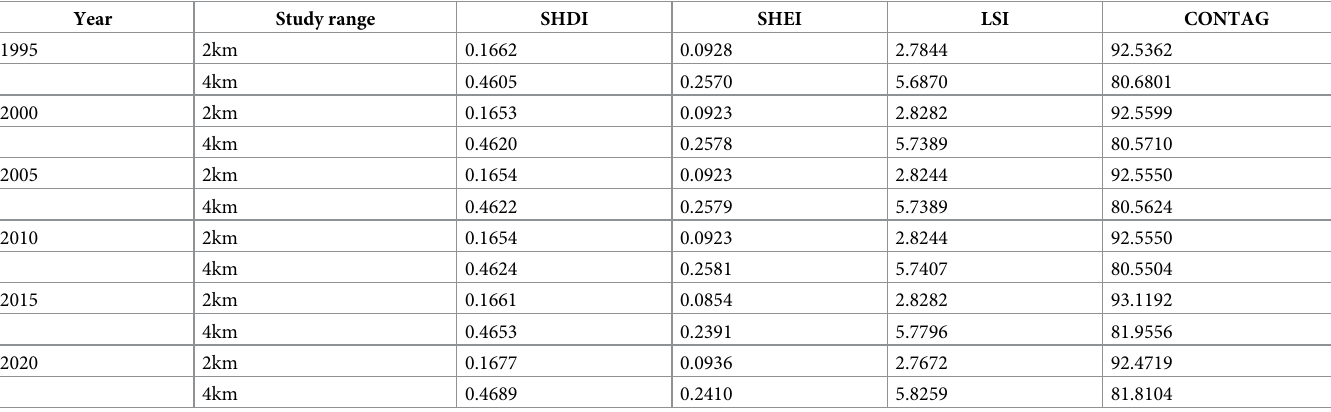
Table 2. Changes in landscape index in two buffer zones from 1995 to